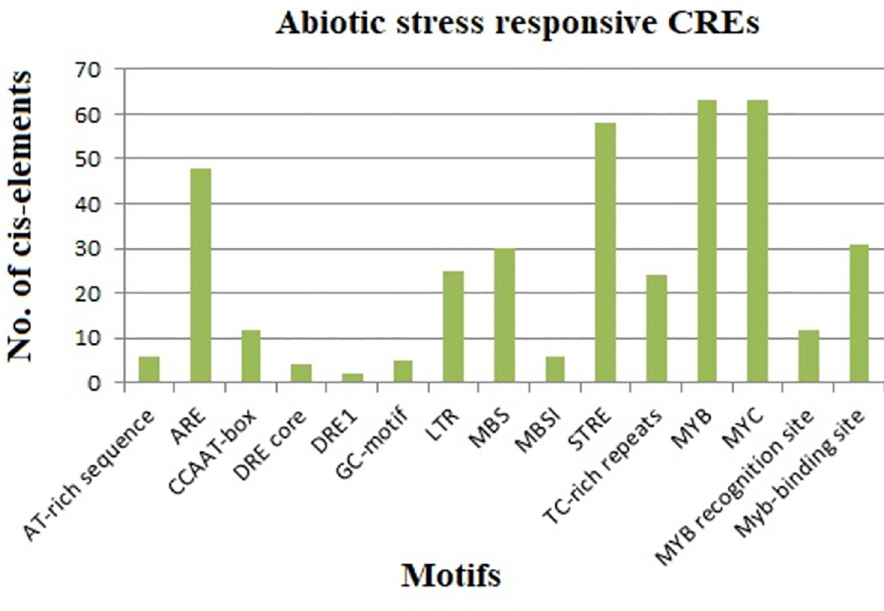
Fig 6. Fifteen types of abiotic stress responsive elements in StDREB gene promoters. Four cis-elements including MYC, MYB, STRE, and ARE showed the highest percentage in DREB gene promoter regions.